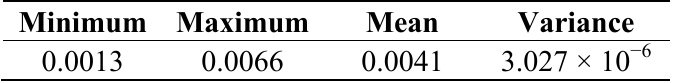
Table 4. the statistical data of EER by random